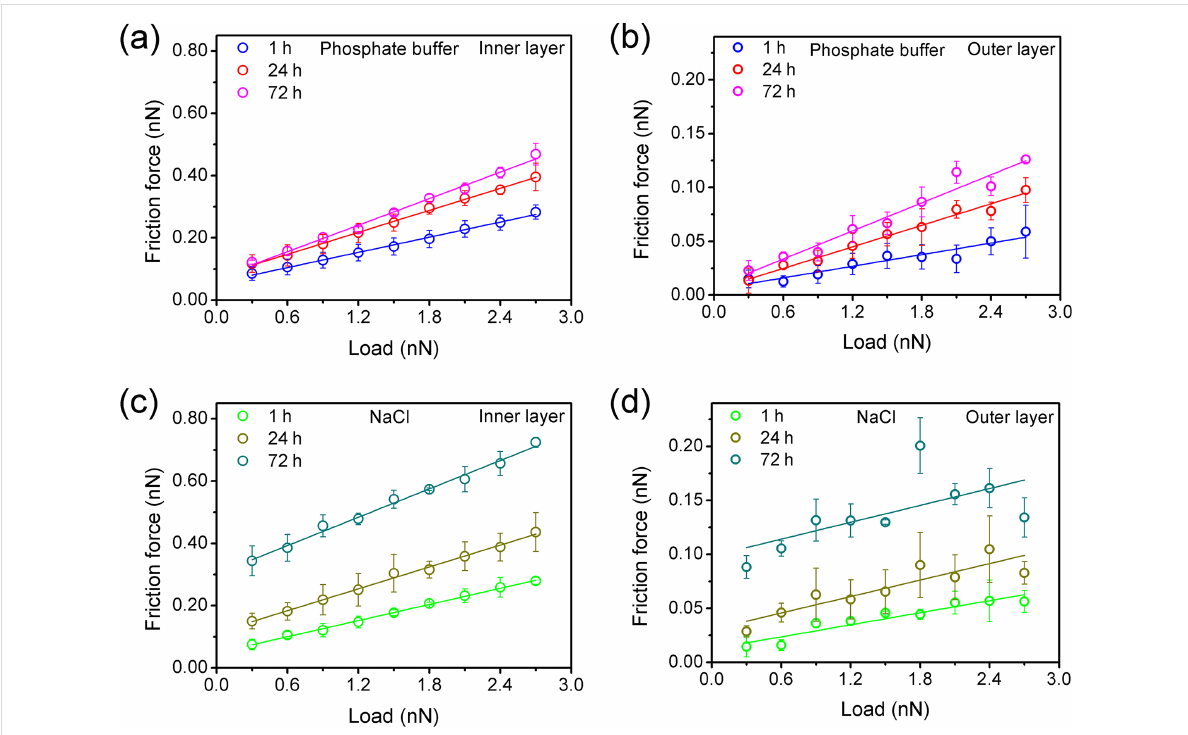
Figure 4: The dependence on the applied normal load during the repetitive scans of: (a) friction force of the inner layer and (b) friction force of the outer layer in phosphate buffer; (c) friction force of the inner layer and (d) friction force of the outer layer in NaCl solution. Solid lines are linear fits. Each data point is the average value of three replica experiments and error bars represent the standard